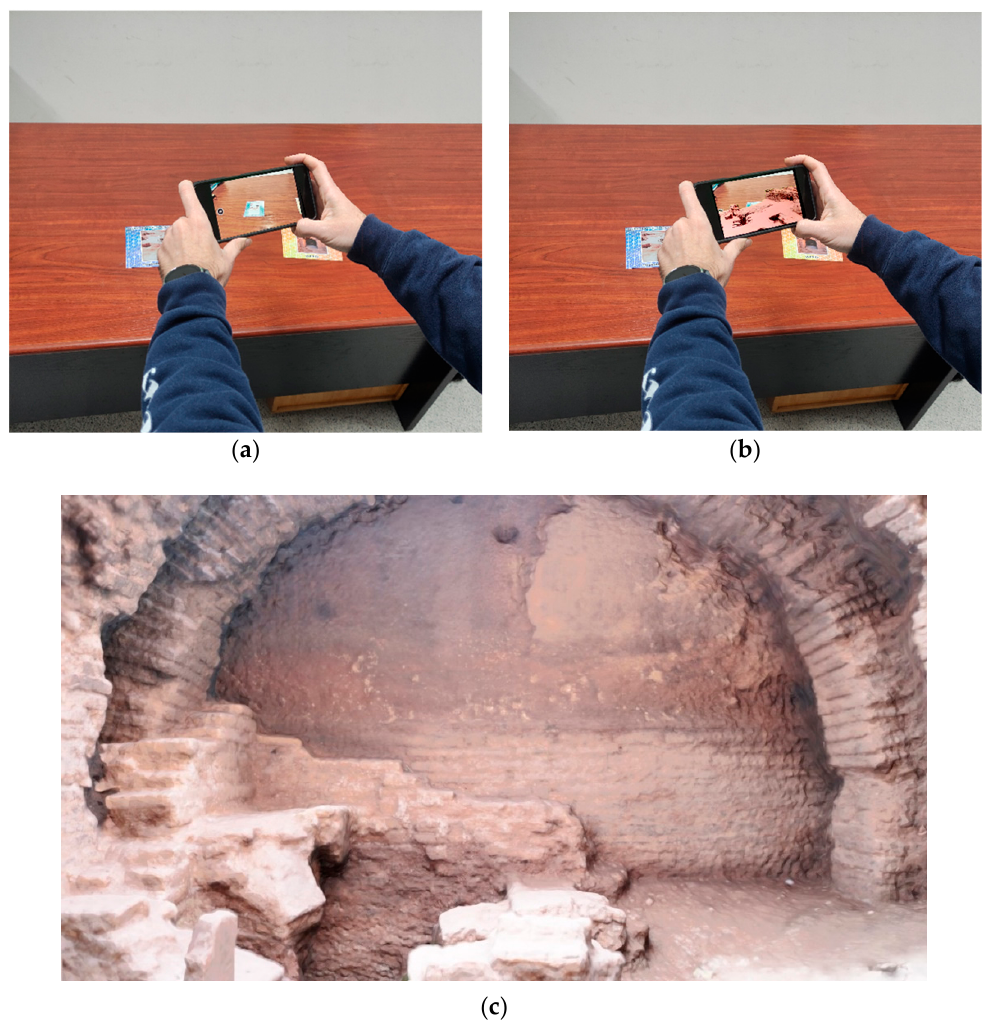
Figure 8. Two moments of the use of our AR app: ( a ) the user focuses the camera on the marker; ( b ) the 3D model of the site is shown over the image of the marker; ( c ) the 3D model of one of the ovens displayed in the AR application.